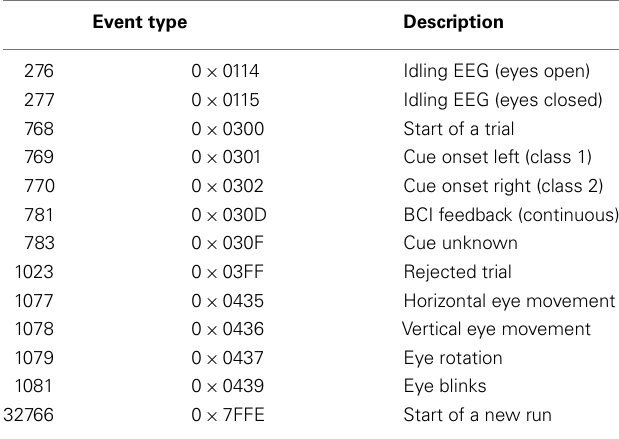
TableA4 | (Data Set 2b). List of event types in data set 2b (the first column contains decimal values and the second hexadecimal